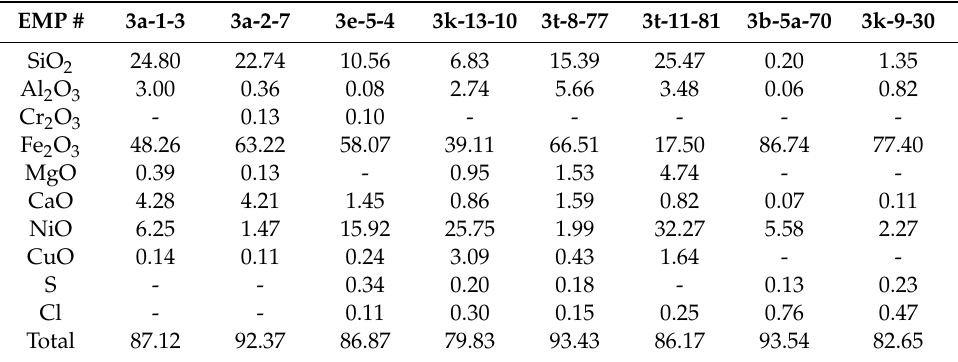
Table 4. Representative EMP analyses of